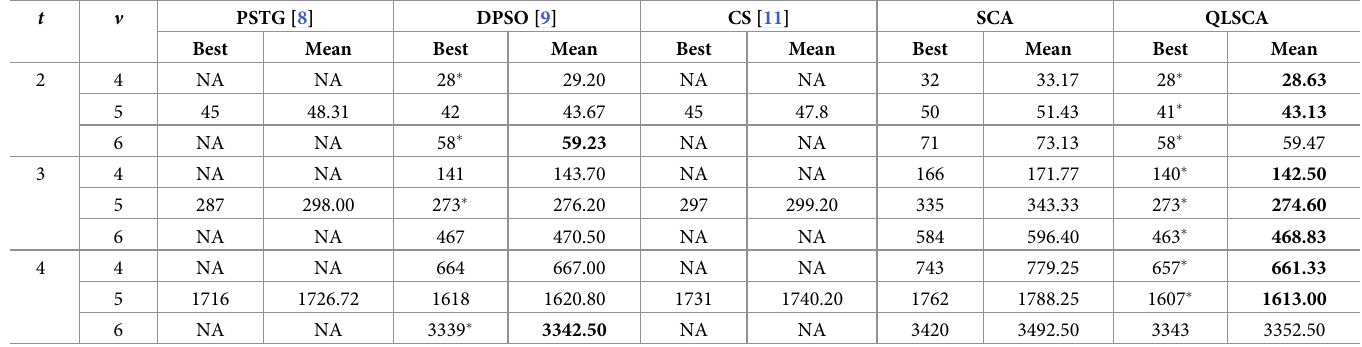
Table 10. Size performance for CA ( N ; t , v 10 ) where t is varied from 2 to 4.